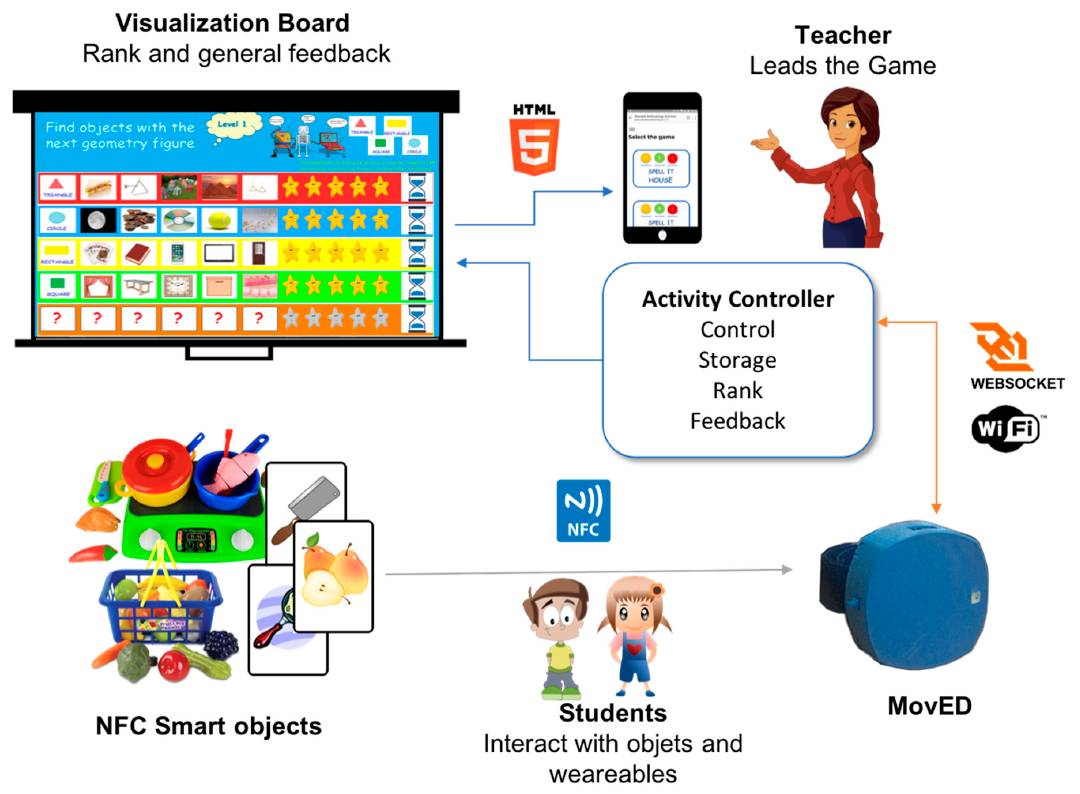
Figure 3. WIoTED system architecture for educational environment.